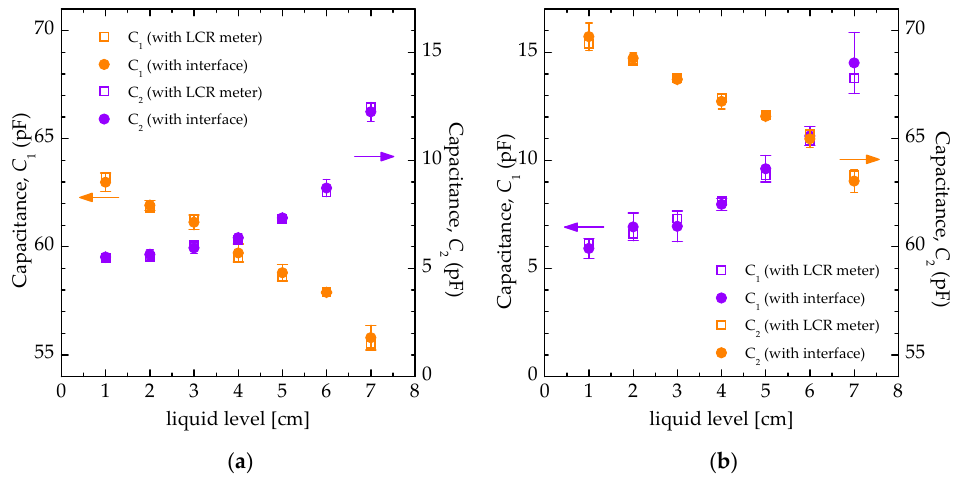
Figure 9. ( a ) Experimental results achieved by using the developed liquid level meter as differential capacitive sensor reported in Figure 8, ( b ) after interchanging C 1 and C 2 .